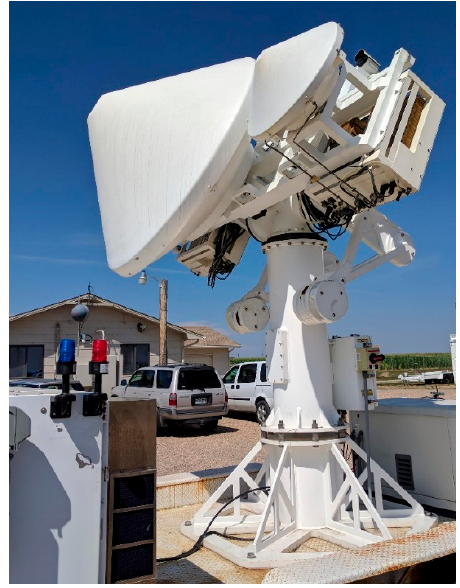
Figure 2. A picture of the D3R radar located at the CSU-CHILL radar